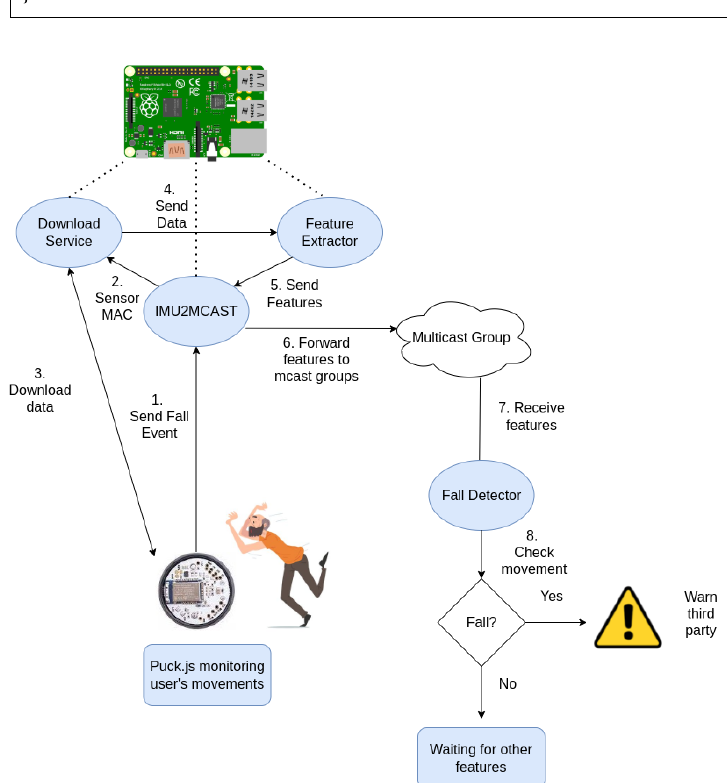
Figure 1. Proposed system